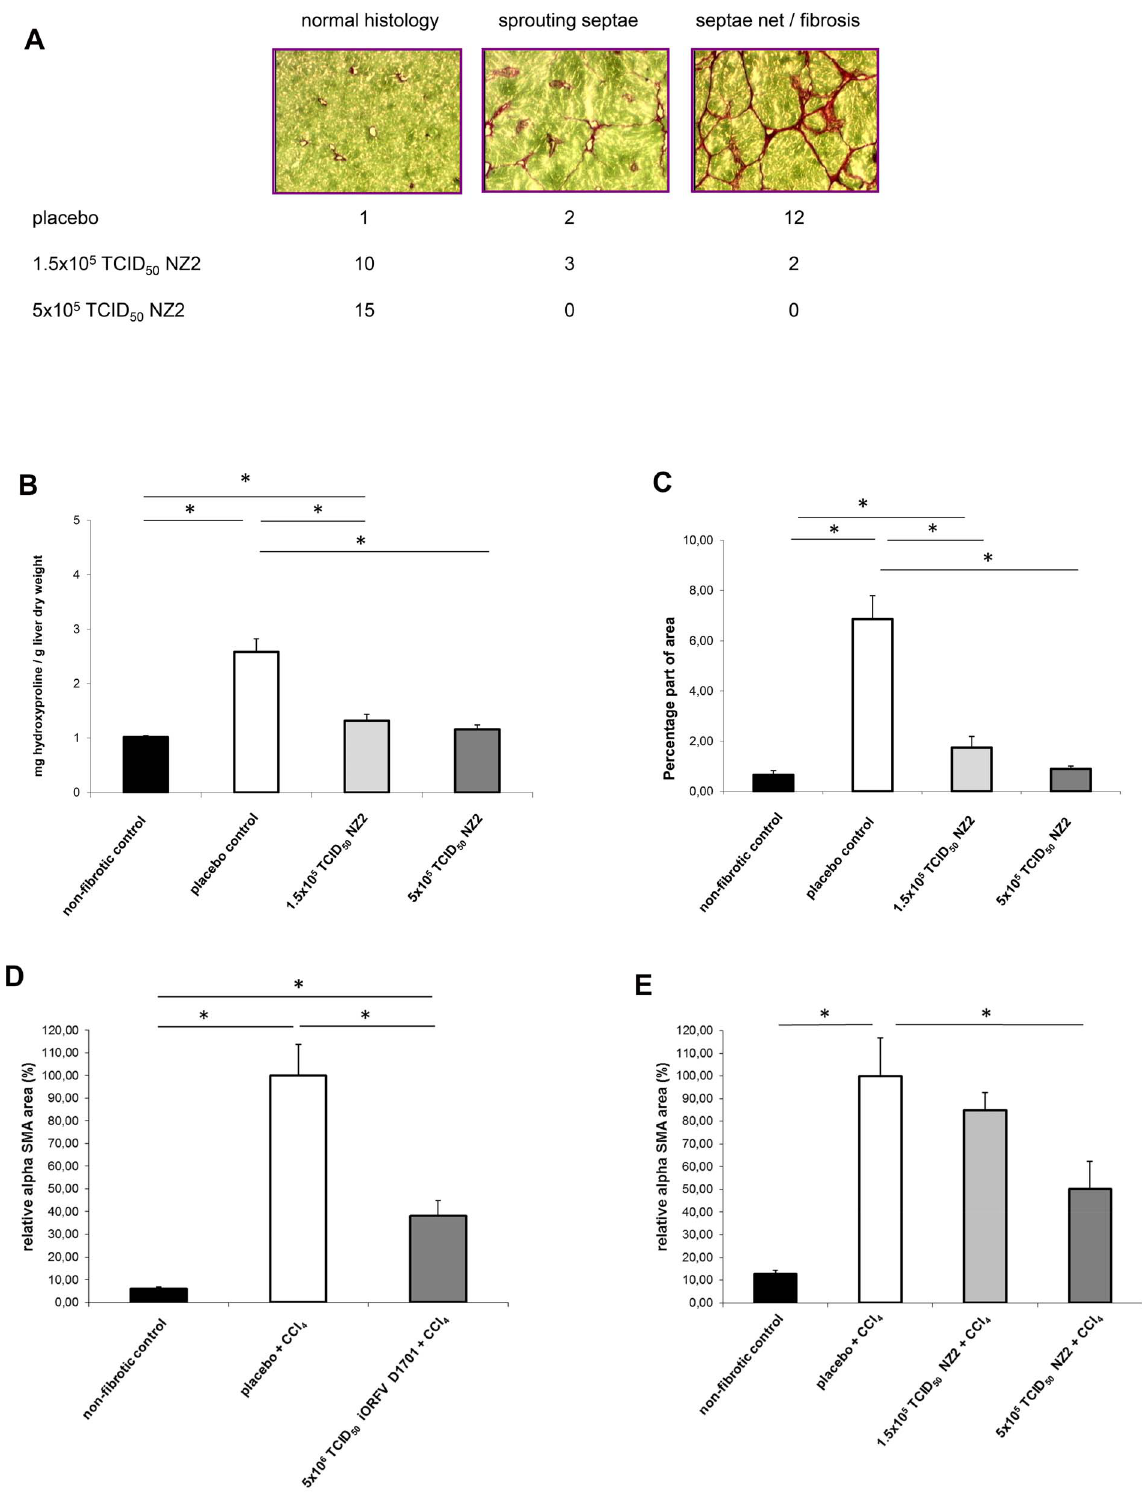
Figure 4. ORFV prevents fibrosis in a model of serum-induced liver fibrosis. iORFV strain NZ2 was administered intraperitoneally at doses of 1.5 6 10 5 TCID 50 /rat or 5 6 10 5 TCID 50 /rat three times per week concomitantly to the fibrotic stimulus (porcine serum). Rats were sacrificed after 7 weeks and livers were subjected to collagen determination. Serial sections were stained with Sirius Red (fibrous collagen) and scored using a three class system a) The figure shows histological sections of rat livers (magnification 25 6 ). The three classes (normal histology, beginning fibrosis with sprouting, unconnected septae and full-blown fibrosis with a network of interconnected septae) are illustrated by histological pictures and the number of animals with this score is given below for the three experimental groups. b) Total collagen was quantified by determination of hydroxyproline. c) Fibrous collagen was quantified by measuring the percentage of area stained by Sirius red (see Material and Methods) in the